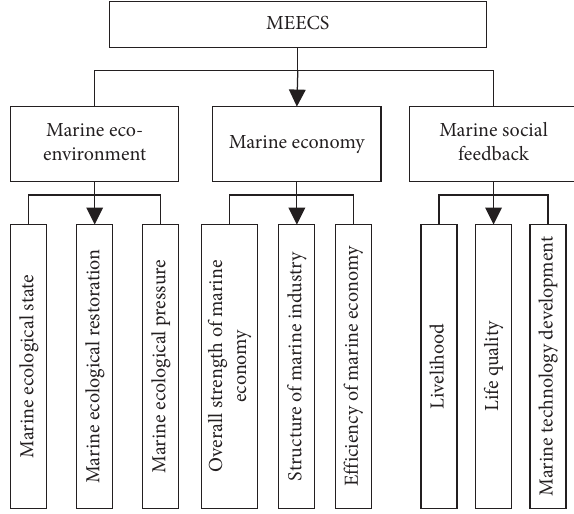
Figure 2: Coordination indices of subsystem development in the complex